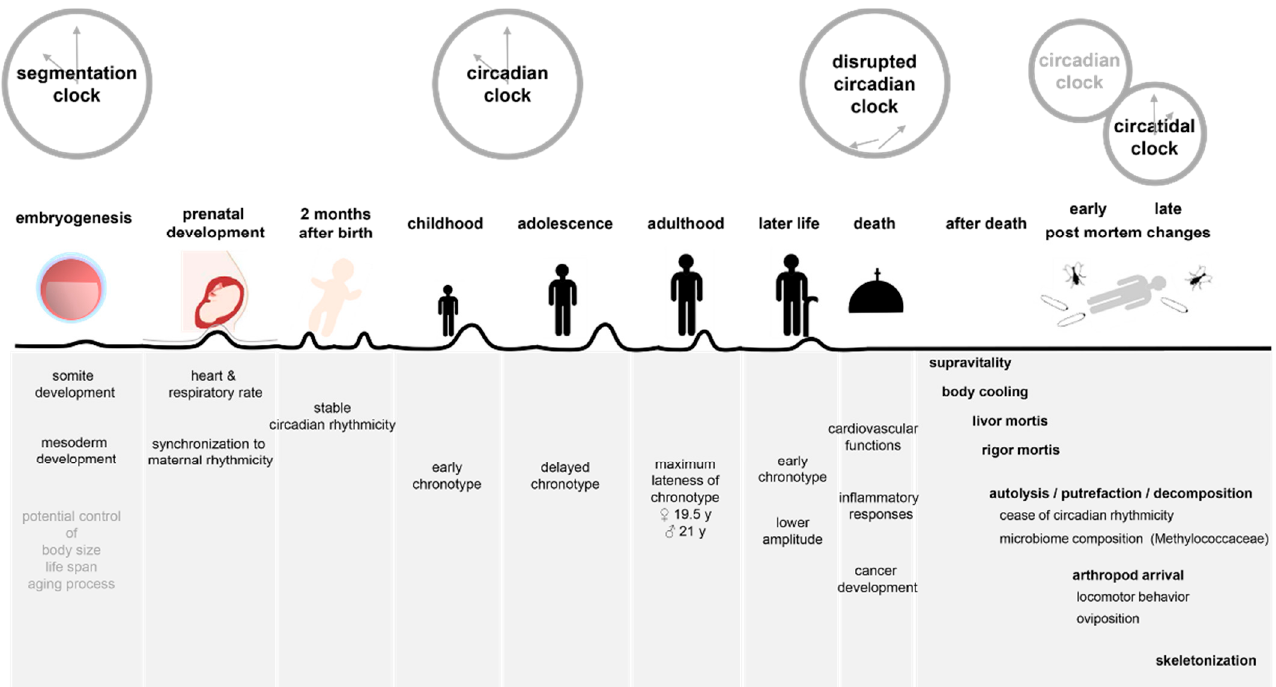
Figure 1. Biological rhythms of life and death. This figure shows how different clock rhythms are involved in the different stages of life as well as the early and late post-mortem changes after